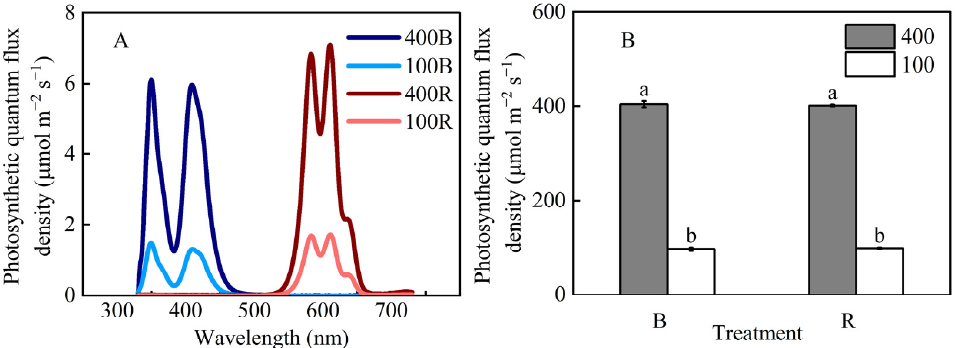
Figure 1. The light environment of different treatments. ( A ) Light quality; ( B ) Light intensity. 400 B, 100 B, 400 R, and 100 R denote 400 µmol m − 2 s − 1 under blue light, 100 µmol m − 2 s − 1 under blue light, 400 µmol m − 2 s − 1 under red light, and 100 µmol m − 2 s − 1 under red light, respectively. The mean ± SE is expressed by each value. Different lowercase letters indicate significant differences between treatments ( p ≤ 0.05).